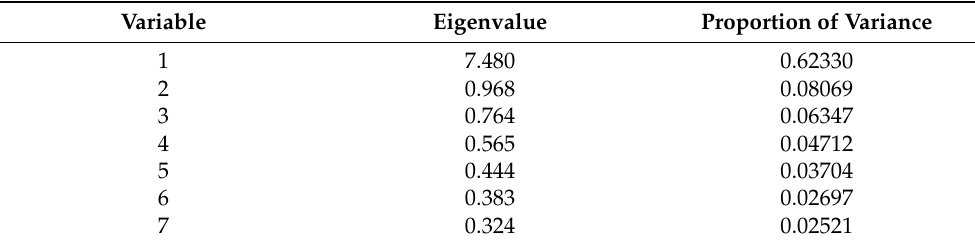
Table 1. Eigenvalues and proportion of explained variance. KMO = 0.922.